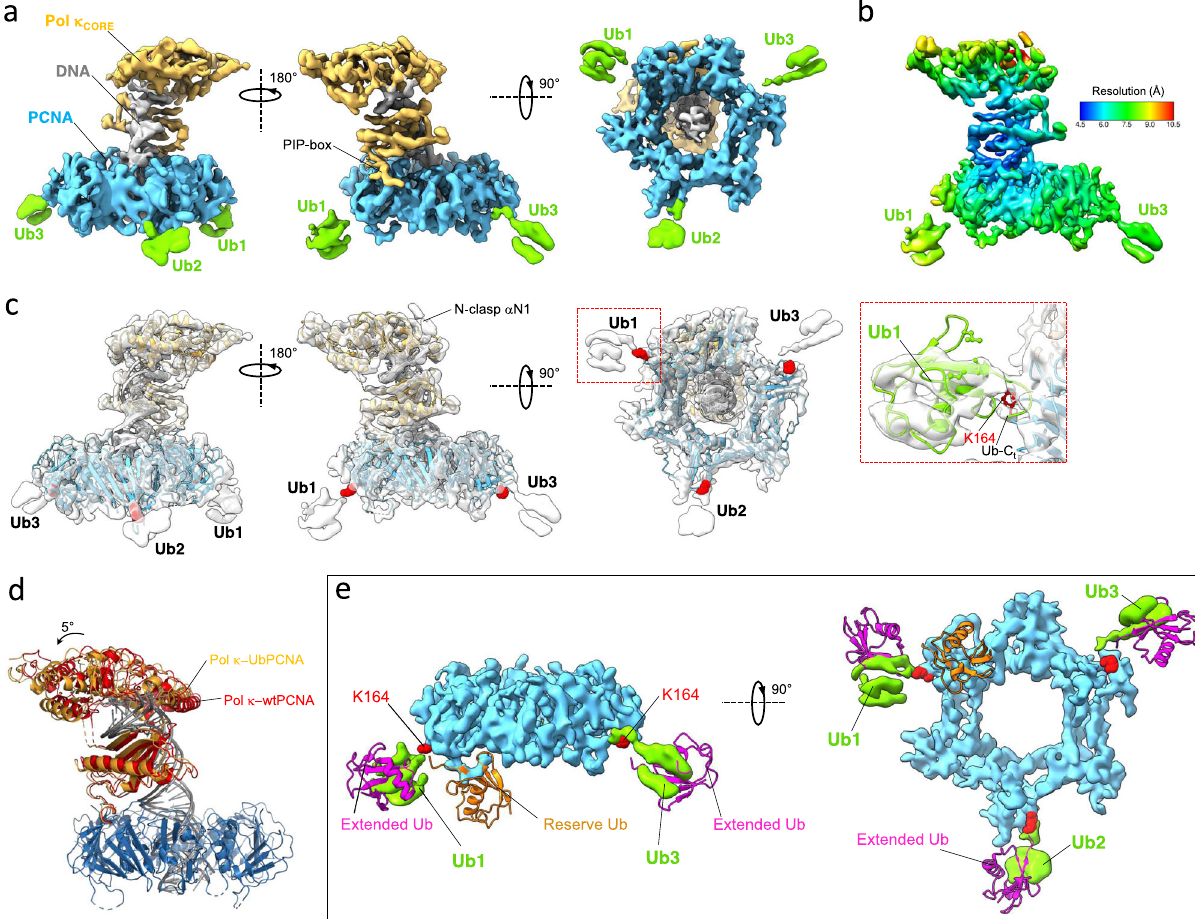
Fig. 4 Cryo-EM structure of the Pol κ − DNA − Ub-PCNA complex. a Different views of the 6.4 Å reconstruction colored by components (Pol κ in orange, PCNA in skyblue, DNA in gray and ubiquitin in green). b Cryo-EM map color-coded by local resolution. c Structural model fi tted into the cryo-EM map. The lysine residues at position 164 are shown as red spheres. The inset shows the rigid-body fi tting of ubiquitin structure into the cryo-EM map at Ub1 position. The ubiquitin L8/I44/V70 residues at the hydrophobic patch, and K164 on PCNA are shown as sticks. d Overlay of structural models of Pol κ bound to wt- PCNA or Ub-PCNA aligned on PCNA, highlighting the slight difference in Pol κ core tilt. e Fitting of crystal structures of yeast split Ub-PCNA with ubiquitin in the “ reserve ” position (PDB ID 3L0W) 45 , and human Ub-PCNA with ubiquitin in the “ extended ” position (PDB ID 3TBL) 46 into the cryo-EM map of the Pol κ − DNA − Ub-PCNA complex. Cryo-EM densities of PCNA and ubiquitin are colored in skyblue and green, respectively. Map portions of Pol κ and DNA were removed for clarity. The lysine residues at PCNA position 164 are shown as red